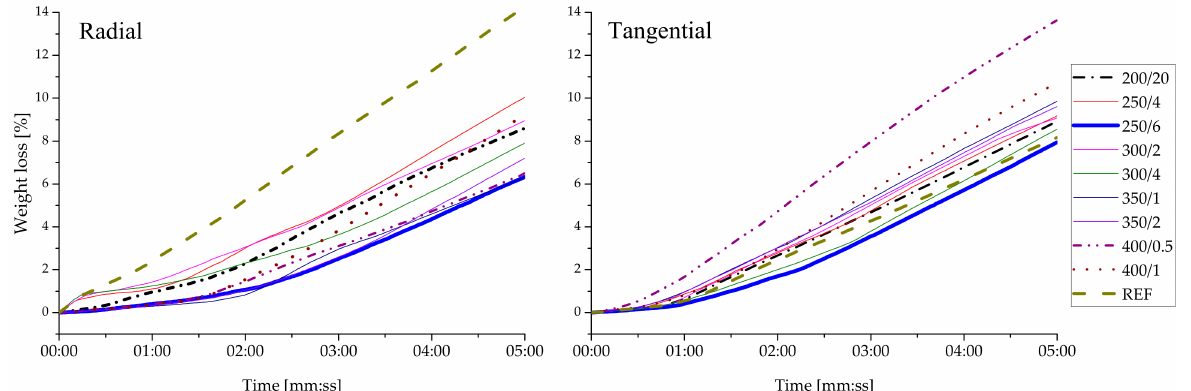
Figure 3. Weight loss of charred specimens recorded within five minutes in the fire resistance